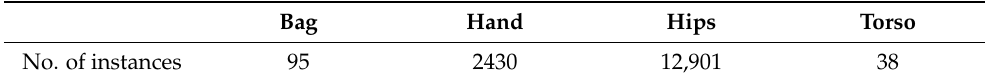
Table 4. The number of instances from each phone location in the test set, as predicted by our location detection